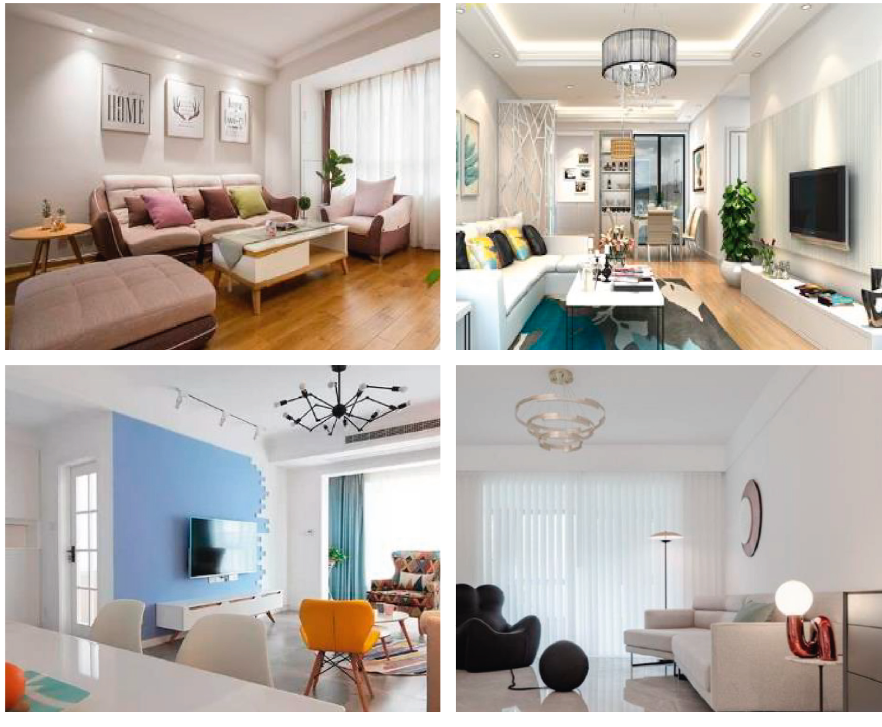
Figure 3: Design vision of nano-titanium dioxide. Table 2: Degradation rate of TiO 2 under different solvothermal